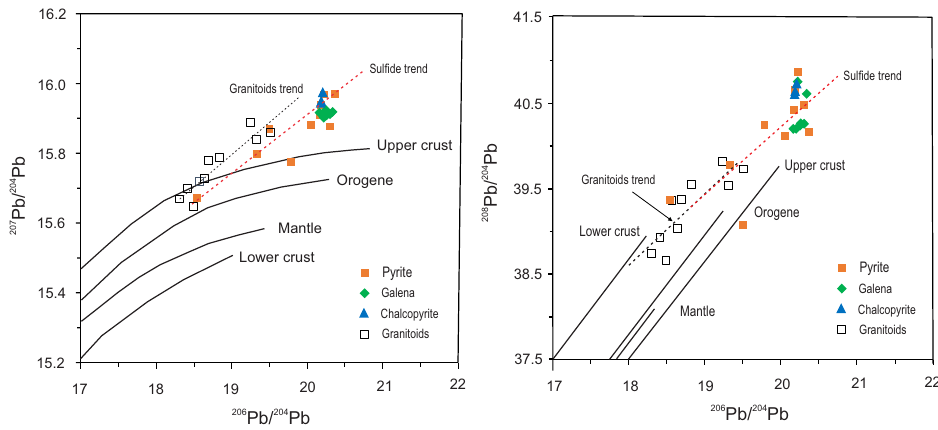
Figure 16. Diagram of lead isotopic composition of the Kargah Cu-Pb polymetallic deposit. The evolution lines for upper crust, orogene, mantle, and lower crust are modified after Zartman and Doe [51]. Lead isotope data of host rock are from Jagoutz et al.